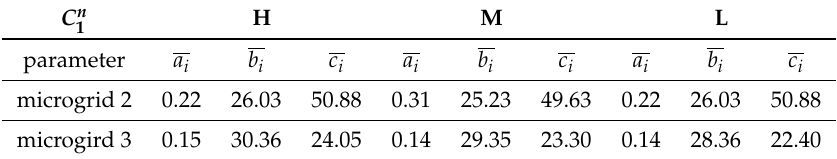
Table 7. Bidding Cost Parameters of Other Microgrids Estimated by Microgrid